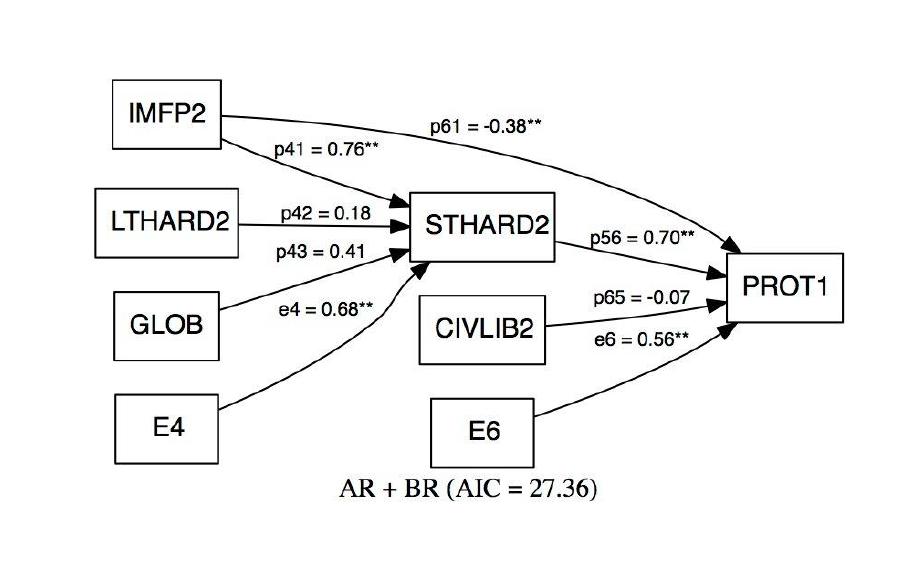
Figure 2. Best Multimodel, Argentina + Brazil (*p <= 0.05, **p <=